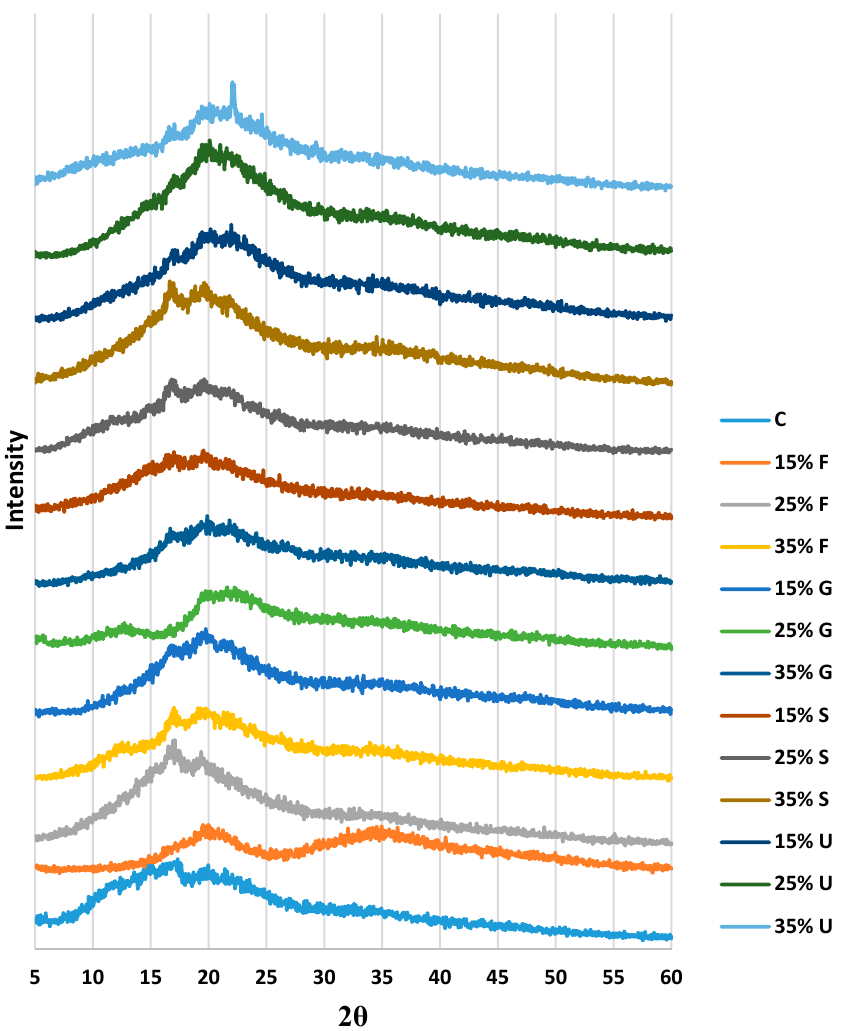
Figure 6. XRD curves of wheat starch films with various plasticizer types at different concentrations.